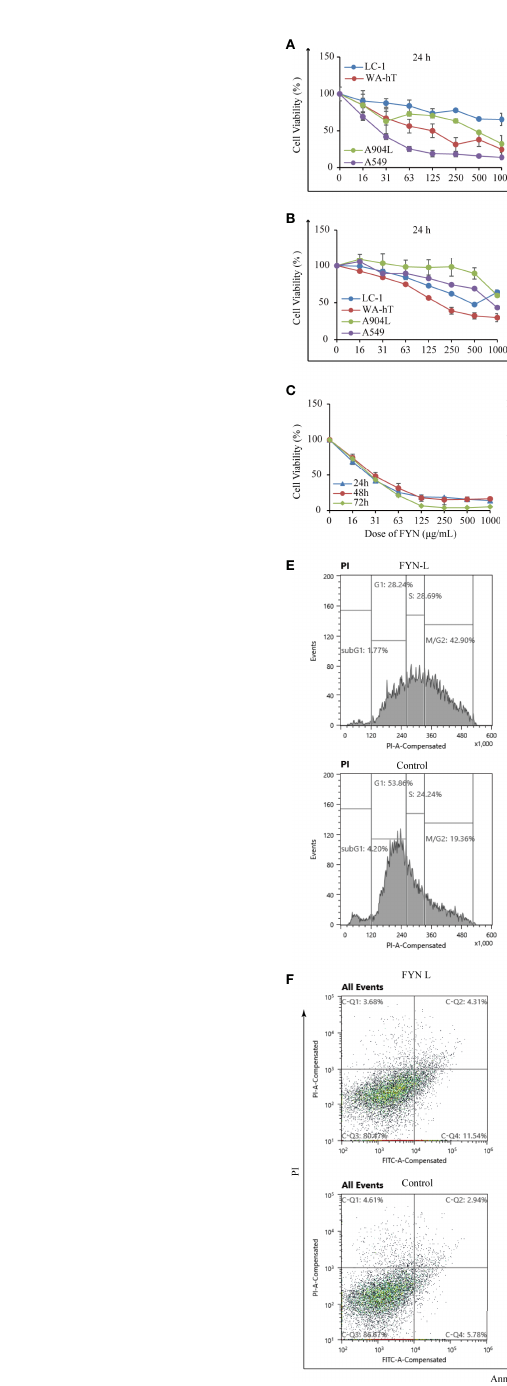
FIGURE 5 | FYN inhibits the proliferation of human lung cancer cells and induces cell cycle arrest and apoptosis. (A) Time and dose responses of four lung cancer cell lines to FYN ( m g/ml). (B) Time and dose responses of the indicated lung cancer cell lines to cisplatin ( m M). (C) Comparison of FYN versus cisplatin effects on A549 cells. (D) The IC50 values at each time point of FYN versus cisplatin. (E) The cell cycle analysis of A549 lung cancer cells after FYN treatment. Flow cytometric pro fi les of PI staining in A549 cells after treatments without (control) or with FYN, cisplatin. The percentages of cells in the G 1 , S, and G 2 /M phases displayed in the fl ow cytometric histogram represent one of the three repeated experiments. These data are statistically processed and shown in a table. (F) FYN induces apoptosis in A549 lung cancer cells. The cells treated without (control) or with FYN, or cisplatin and stained by FITC-conjugated Annexin V and PI. Then, the cells were analyzed by dual parameter fl ow cytometry. The percentages of quadrant fractions displayed in the fl ow cytometric plots represent one of the three repeated experiments. These data are statistically processed and shown in a